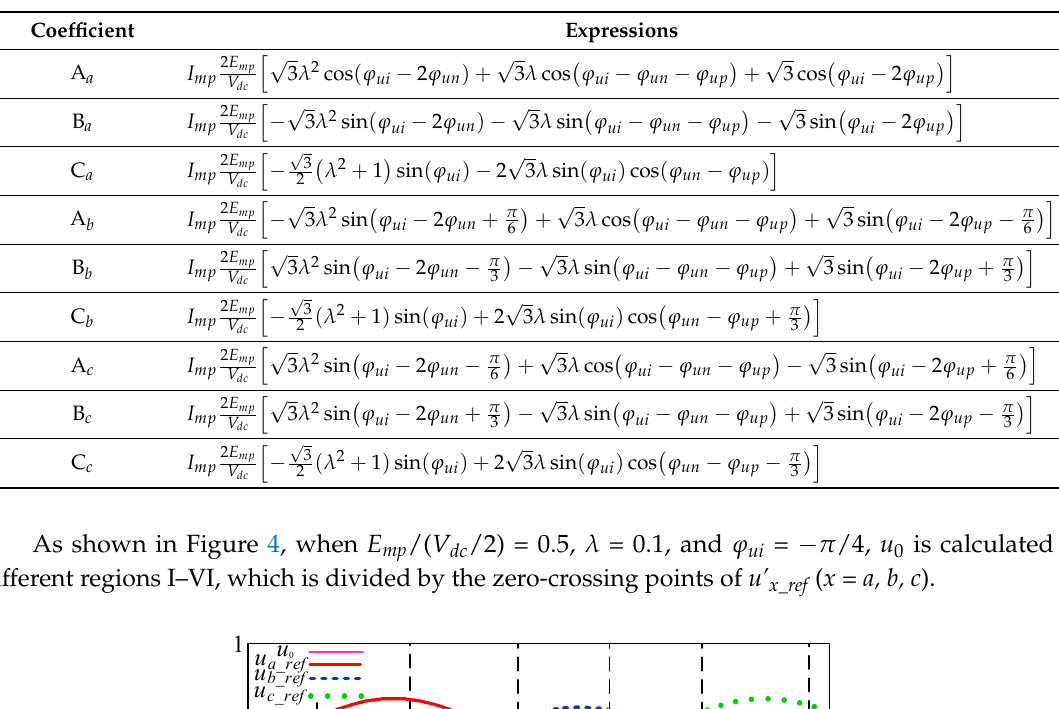
Table 1. Expressions of A i , B i and C i .